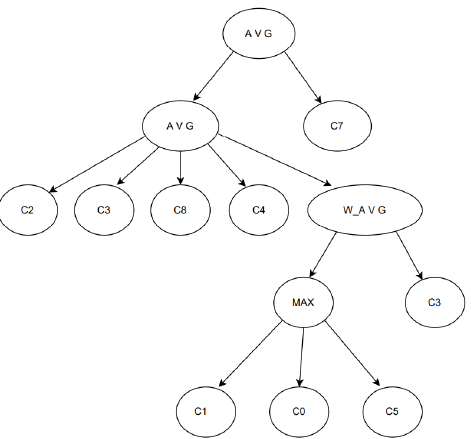
Figure 3. An example of a GPC graph: the nodes represent one classifier or one aggregation operator between one or more classifiers. Some operators are max, average, and weighted average. The classifiers range from C 0 to C 8